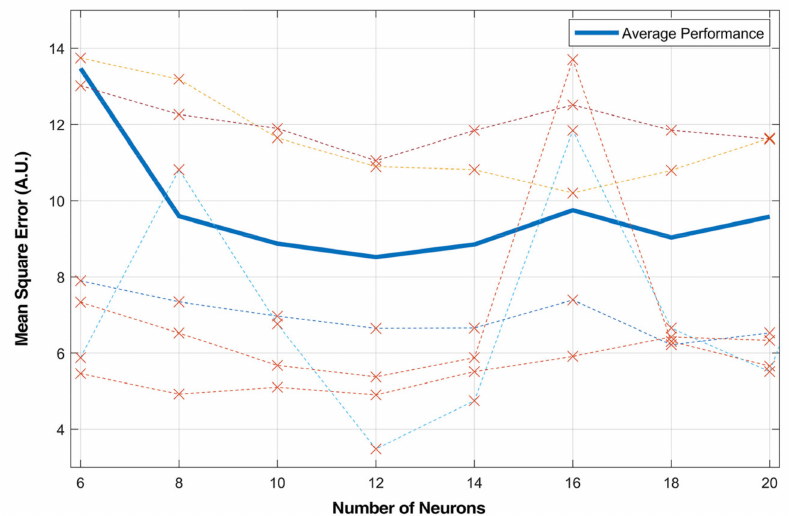
Figure 9. Mean square error with different numbers of neurons. The dashed lines are MSE of different subjects. The average performance was calculated from all subjects.